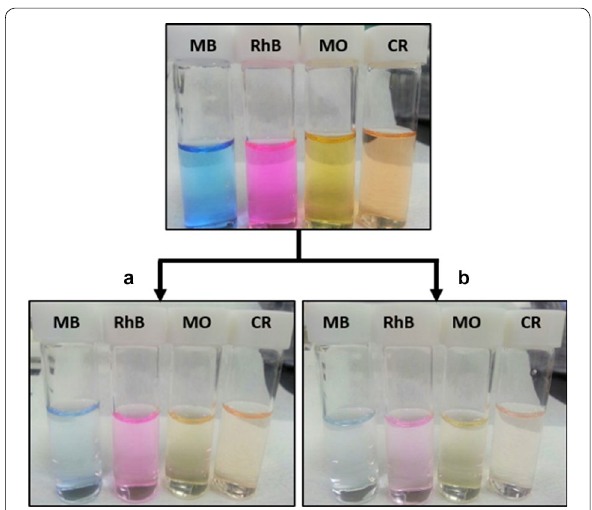
Fig. 7 The color of the treated dye solutions using GC_15 composite hydrogel column via a direct filtration and b filtration after 24 h